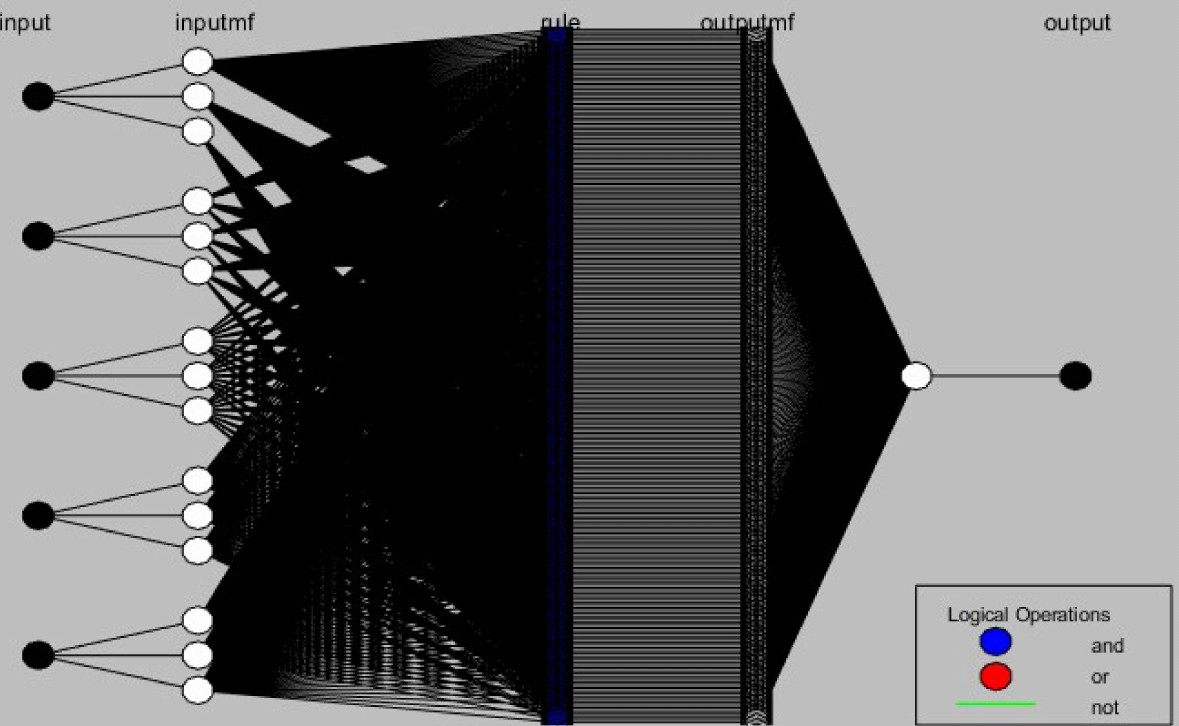
Figure 3. ANFIS multilayer architecture.